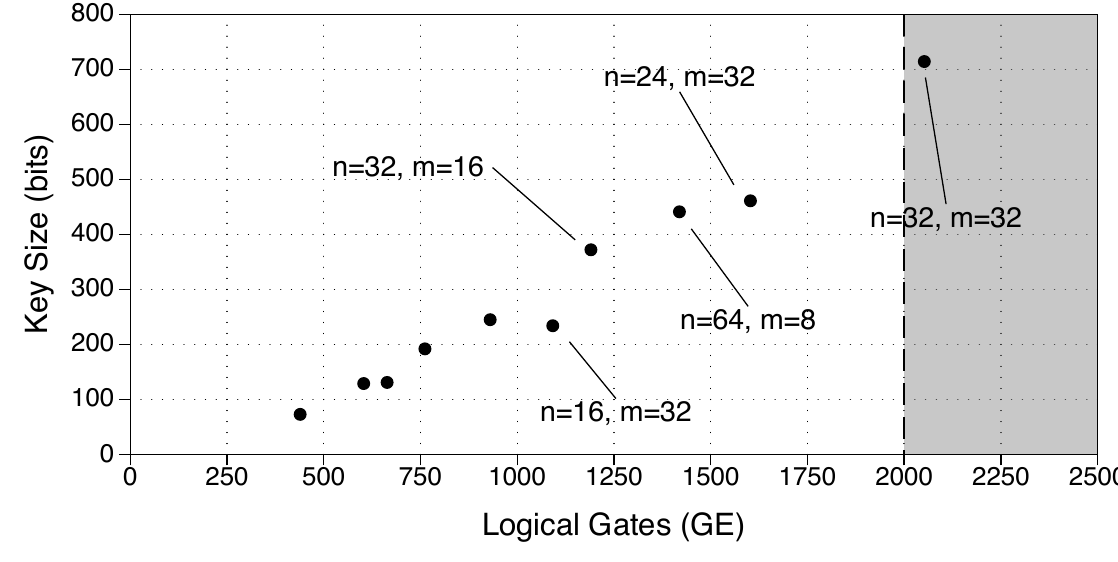
Figure 2. Different combinations present suitable trade-offs between security and implementation